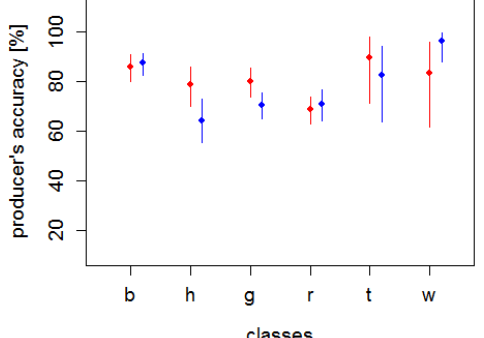
Figure 6. Producer’s accuracy with confidence intervals for two methods of classification (Red=DT, blue=SVM, n c =91). Abbreviations of classes are explained in Table 2.